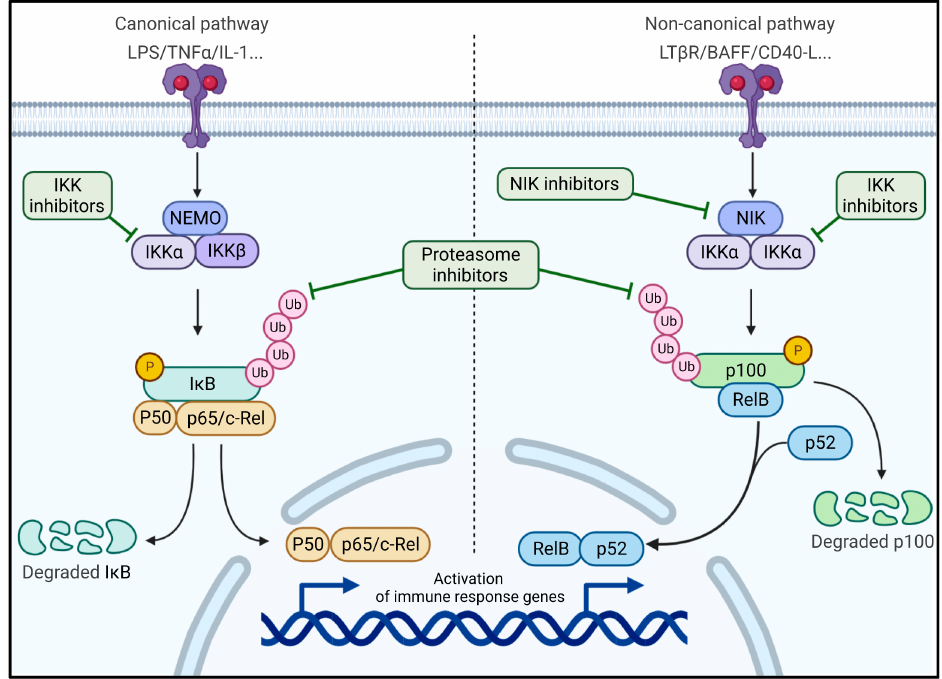
Figure 2. Canonical and non-canonical NF- κ B pathways. Plck-GAPDH mice initially upregulate the canonical NF- κ B pathways ( left ) in the CD4+ T cells before disease symptoms are evident. This activation persists for 18–24 months and induces an inflammatory environment. When the mice develop lymphoma, the tumoral CD4 Tfh cells upregulate the non-canonical NF- κ B pathway ( right ). This was confirmed by the upregulation of NIK in Tfh lymphoma cells, which are accompanied by GC B cells in which NIK is also upregulated. Several inhibitors of the NF- κ B pathways are indicated and might represent a new therapeutic option for AITL. Figure generated by